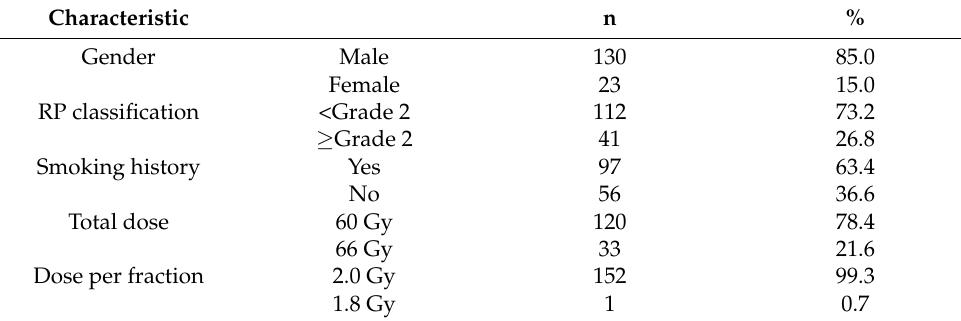
Table 1. Summary of patient characteristics.